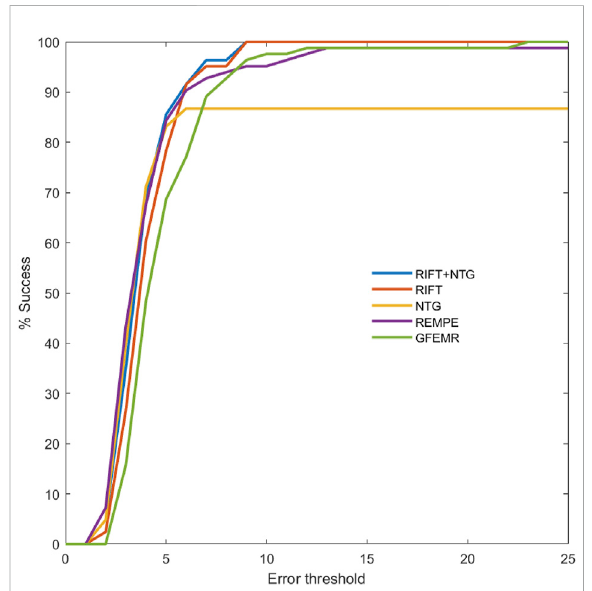
FIGURE 6 Registration success plot of the registration results in FI- LORE. The x -axis marks, in pixels, the registration error threshold underwhichregistration isconsideredto besuccessful. The y -axis marks the percentage of successfully registered image pairs for a given threshold. The AUCs of RIFT, NTG, RITF + NTG (proposed), REMPE, and GFEMR are 0.841, 0.755, 0.850, 0.840, and 0.808,